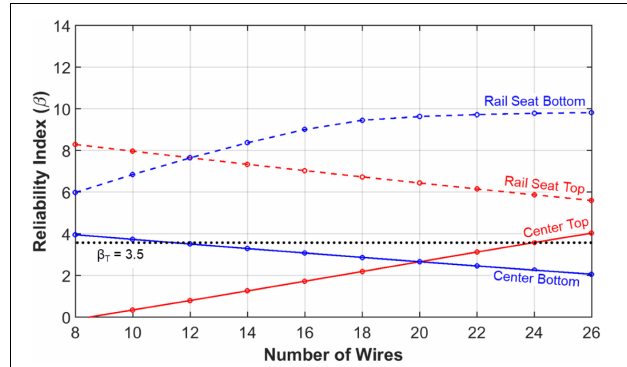
FIGURE 12 | HAL freight center bending moment structural reliability indices ( β ) as a function of number of wires, while holding other parameters constant.